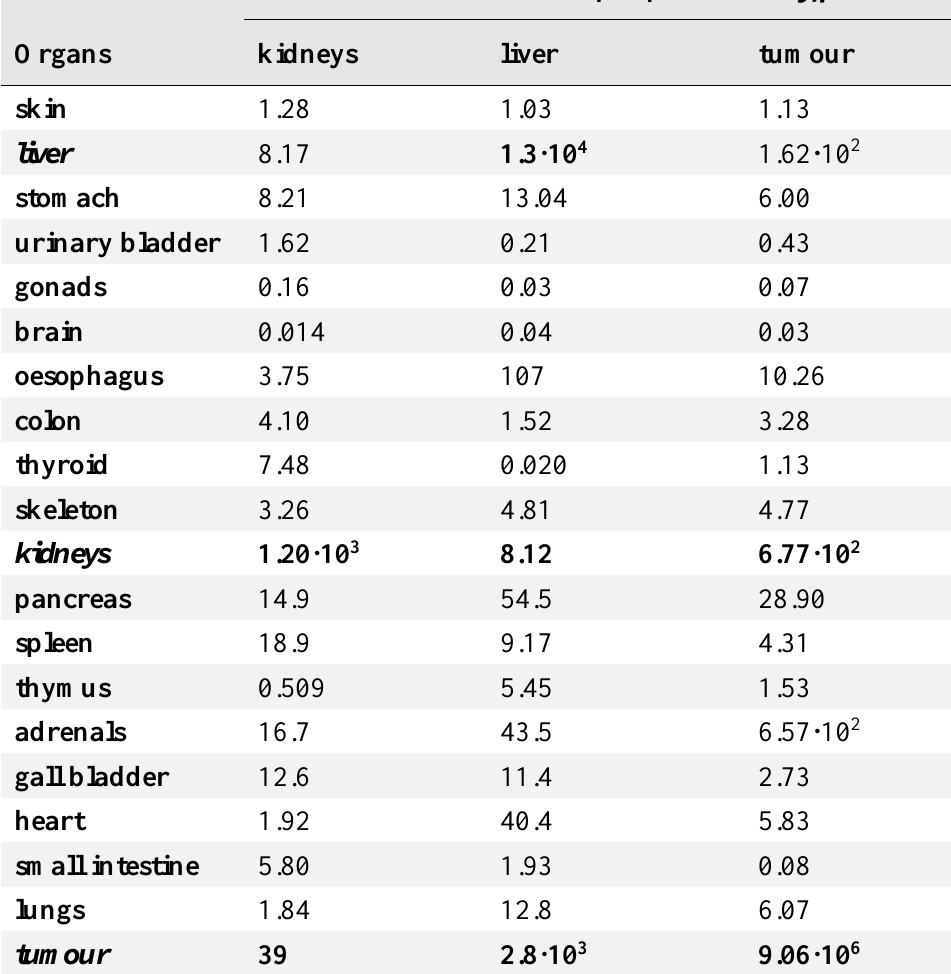
Table1. Results of MCNP5/X calculations for absorbed dose per particle in organs of human body (kidneys, liver and tumour are the sources of